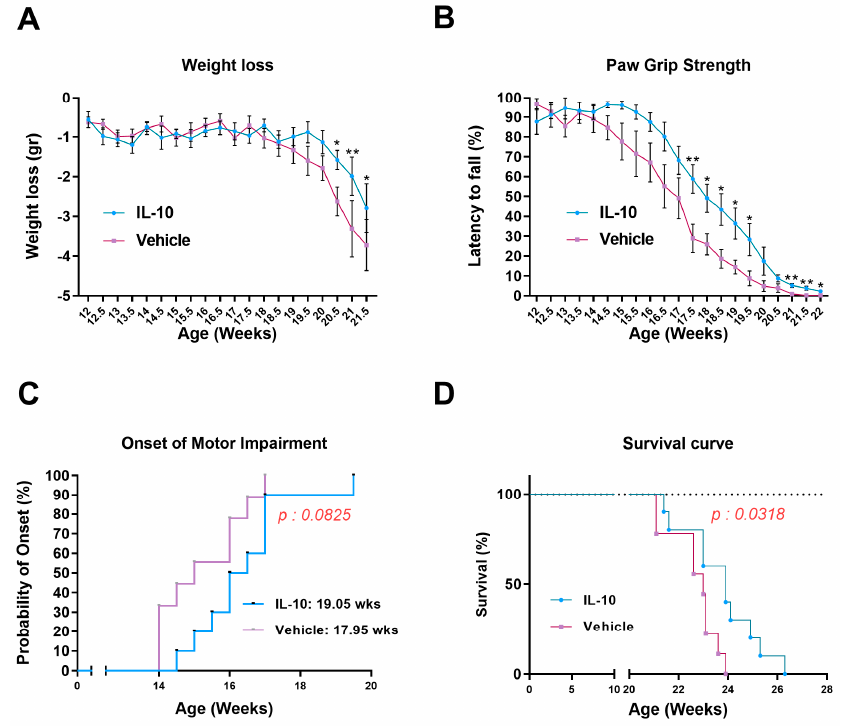
Figure 1. Intramuscular IL-10 administration ameliorates the disease progression and extends the survival of C57-SOD1G93A mice. ( A ) Body weight loss for IL-10-treated ( n = 10) and PBS-treated ( n = 9) C57-SOD1G93A mice. The data are reported as the mean ± SEM for each time point. * p < 0.05, ** p < 0.01 by repeated-measures ANOVA with Sidak’s post-analysis. ( B ) Paw grip endurance (PaGE) test for IL-10-treated ( n = 10) and PBS-treated ( n = 9) C57-SOD1G93A mice. The data are reported as the mean ± SEM for each time point. * p < 0.05, ** p < 0.01 by repeated-measures ANOVA with Sidak’s post-analysis. ( C ) IL-10-treated mice had a delayed onset of motor impair- ment compared to PBS-treated mice. p <0.0825 by Mantel–Cox log-rank test. ( D ) IL-10-treated mice had a delayed end of life compared to PBS-treated mice. p <0.0318 by Mantel–Cox log-rank test.